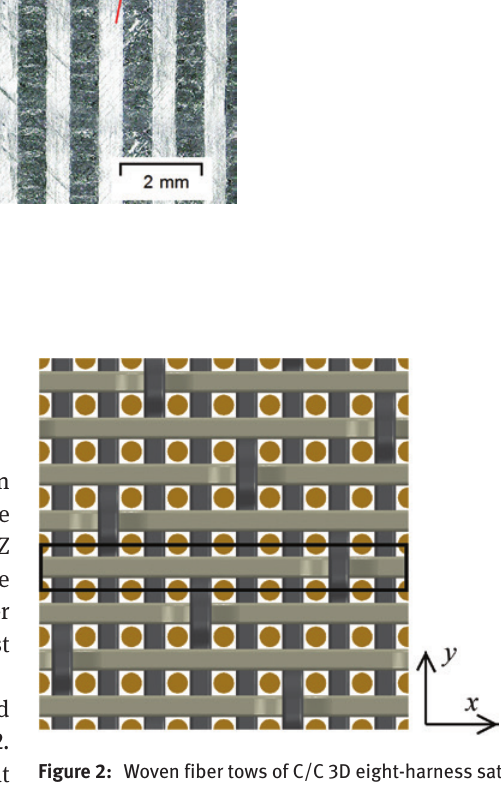
Figure 2: Woven fiber tows of C/C 3D eight-harness satin weave com- posites, traditional RUC (whole image), and ORUC (in square box).